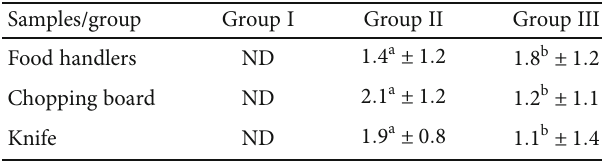
Table 6: Hygiene practices and cross contamination in restaurants among groups based on Enterobacteriaceae (log cfu/cm 2